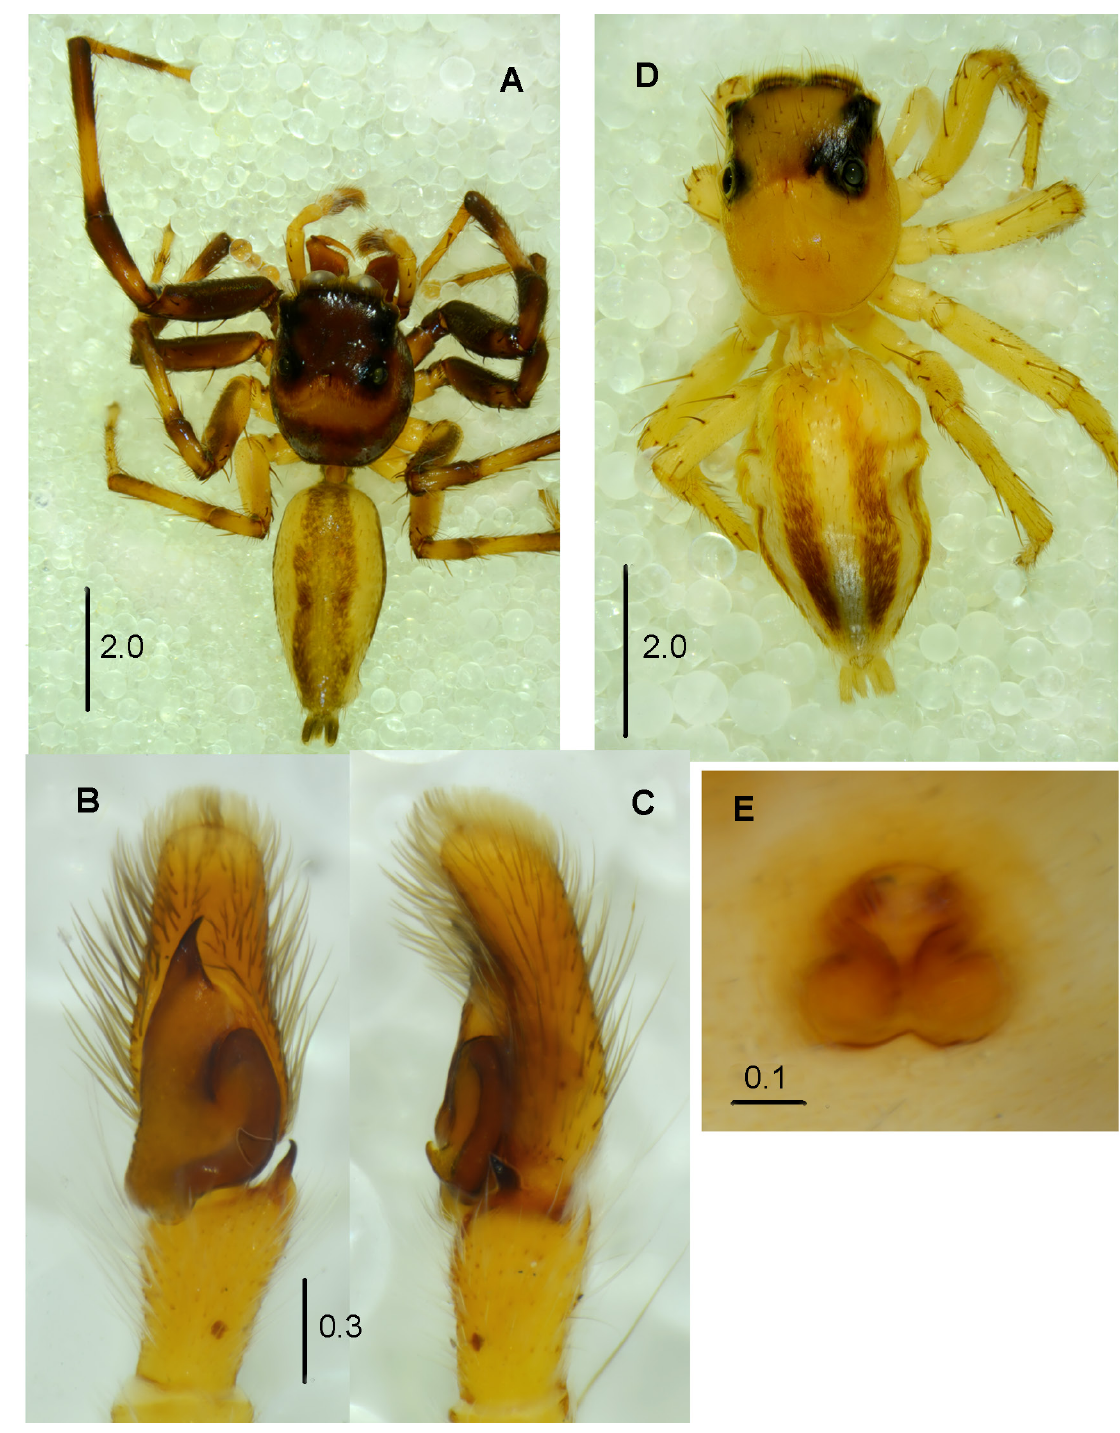
Fig. 46. Phintella occidentalis sp. nov. A–C . Holotype, ♂ (MNHN). D–E . Paratype ♀, (MNHN). A . Habitus of male, dorsal view. B . Palpal organ, ventral view. C . Palpal organ, lateral view. D . Habitus of female, dorsal view. E .